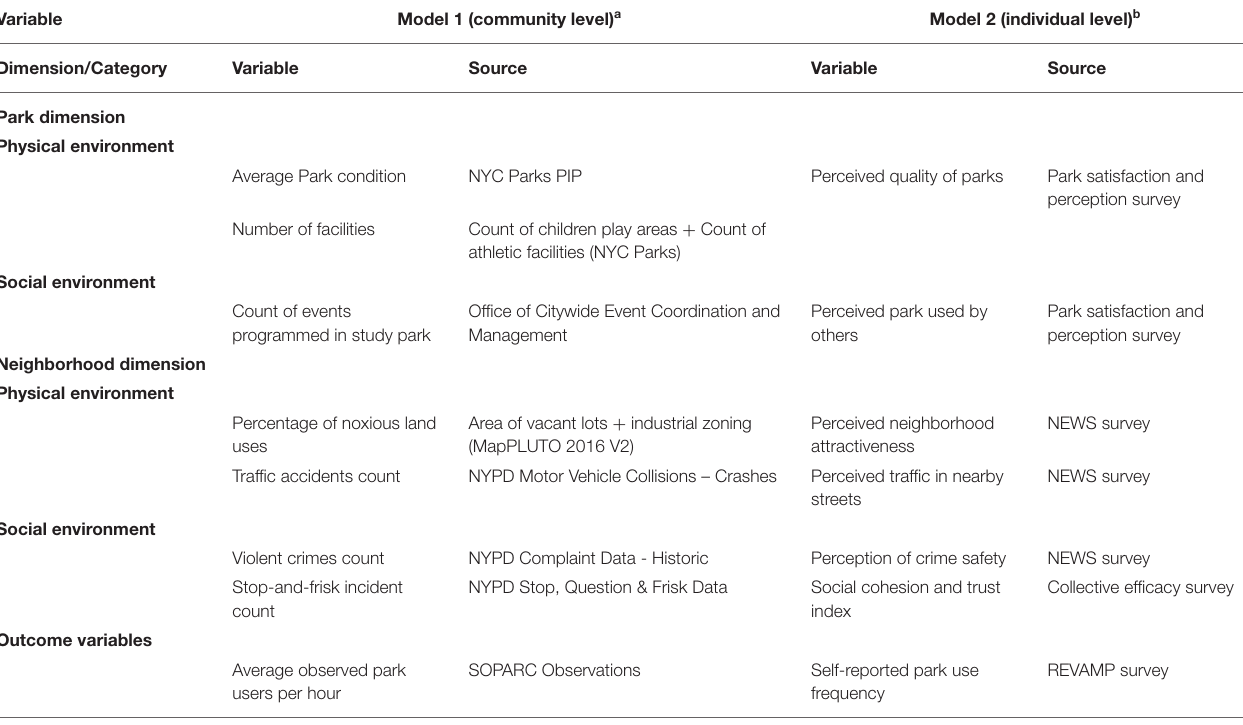
TABLE 1 | Variable categories and dimensions for Model 1 and Model